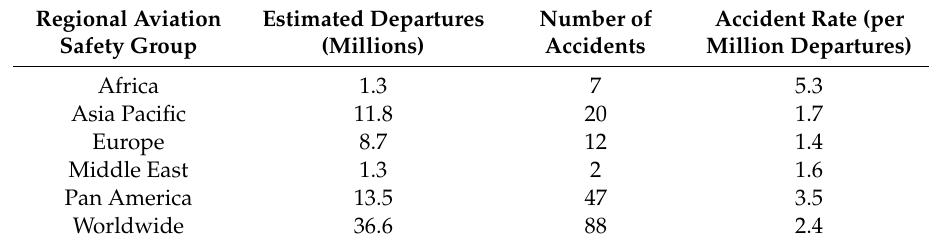
Table 2. Departures and accidents rates by Regional Aviation Safety Group (RASG) region of occurrence. Adapted from International Civil Aviation Organisation (ICAO)